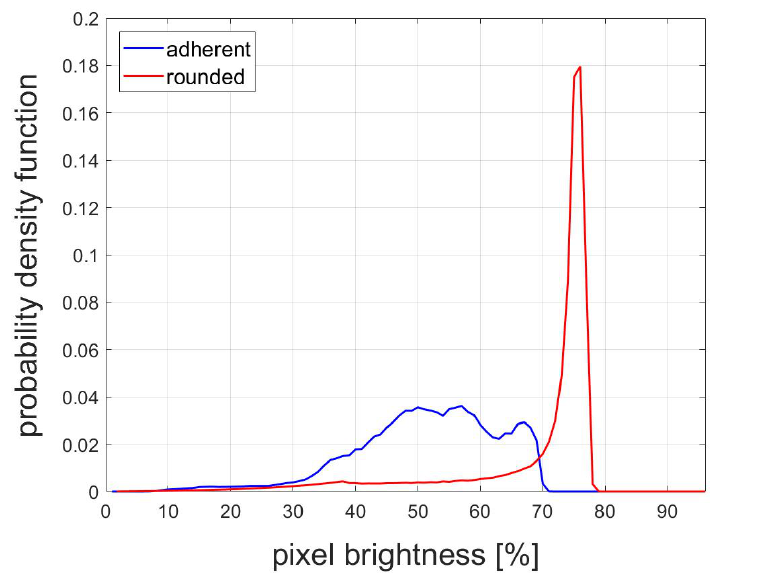
Figure 8. Probability density functions of pixel brightness in the horizontal axis (brightness scale from 1 to 96) for adherent cells (blue) and rounded cells (red).